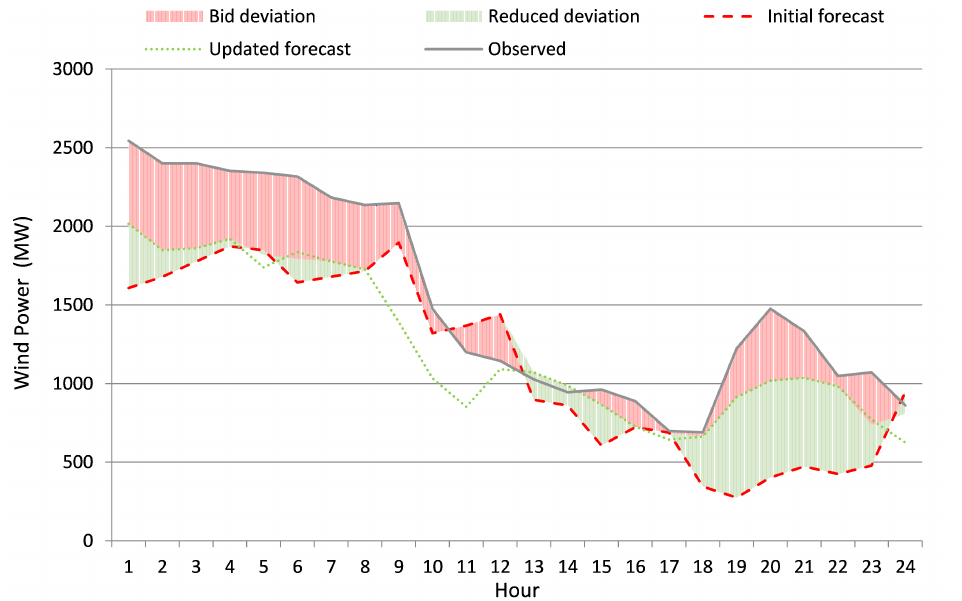
Figure 8. Initial and updated forecasts, deviations and observed